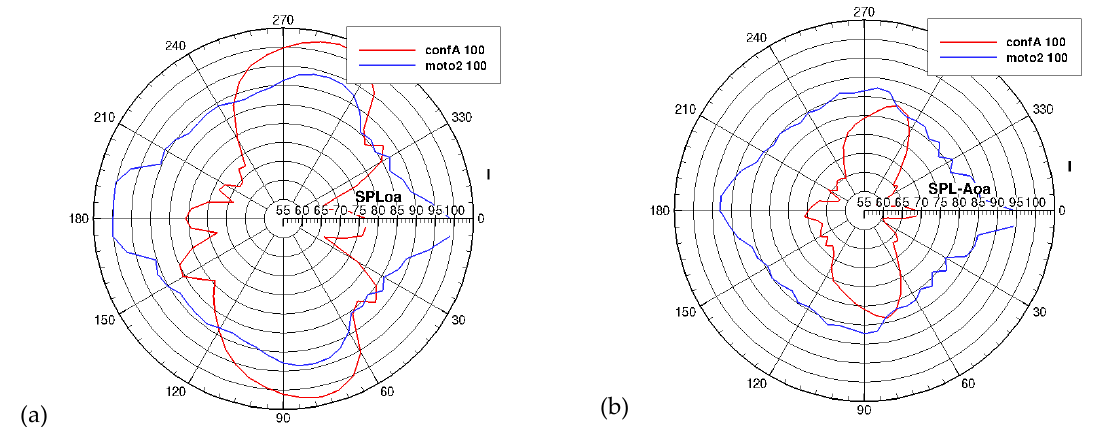
Figure 24. Comparison between Configuration A and Motorization 2; OASPL values on the horizontal XY plane ( a ), A- weighted values on ( b ). Flight condition Descent 40% ETR.